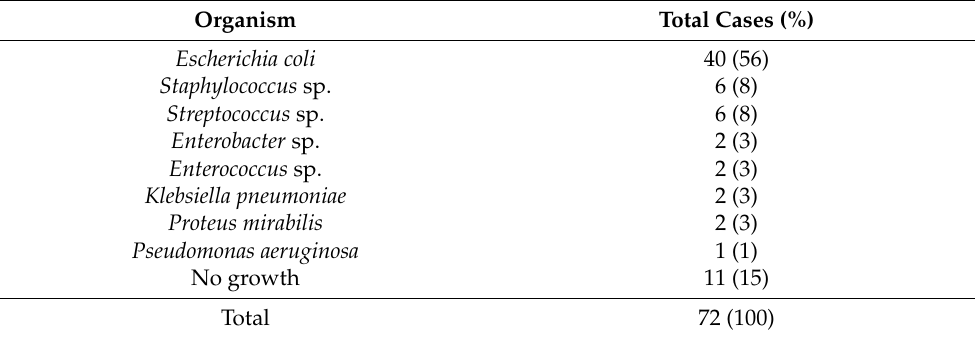
Table 1. Bacterial species isolated from the uterus in bitches with pyometra. Organism Total Cases (%) Escherichia coli 40 (56) Staphylococcus sp. 6 (8) Streptococcus sp. 6 (8) Enterobacter sp. 2 (3) Enterococcus sp. 2 (3) Klebsiella pneumoniae 2 (3) Proteus mirabilis 2 (3) Pseudomonas aeruginosa 1 (1) No growth